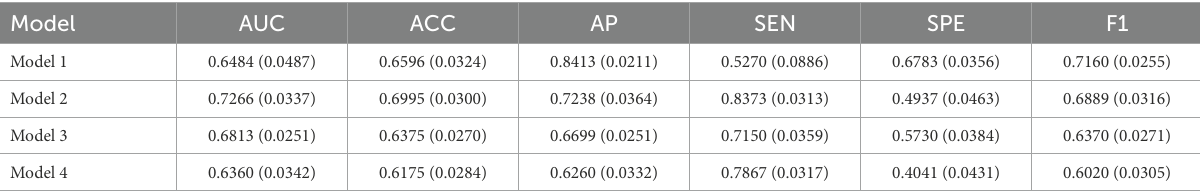
TABLE 2 Mean and SD (inside brackets) of six performance metrics of the prediction models. Model AUC ACC AP